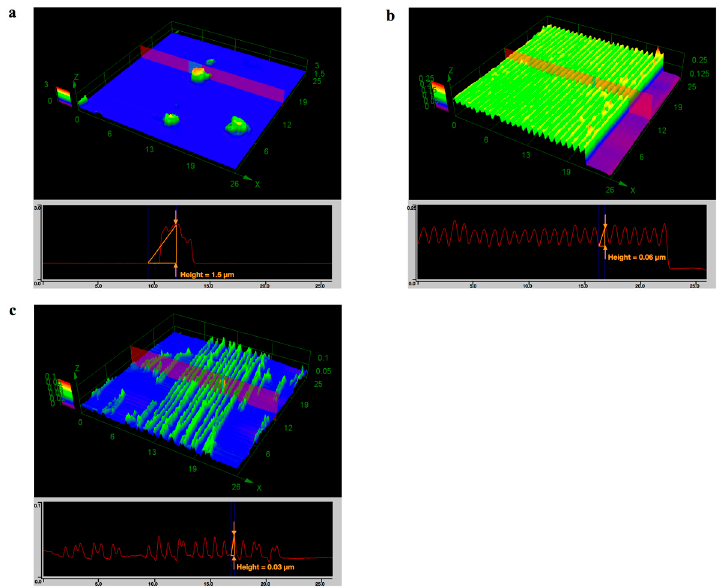
Figure 4. Morphologies of patterned films fabricated using PDMS templates with surface gratings visualized by a reflection confocal laser microscope. ( a ) Dopamine hydrochloride alone; ( b ) GC–dopamine 1:1; and ( c ) GC alone. The measured area was 26 µm × 26 µm. The height scale was ( a ) 3 µm and ( b ) 0.25 µm and ( c ) 0.1 µm, and the vertical axis in the 3D images in ( b , c ) were magnified 50×. Film edges were intentionally selected for observation to show the exposed substrate surface.